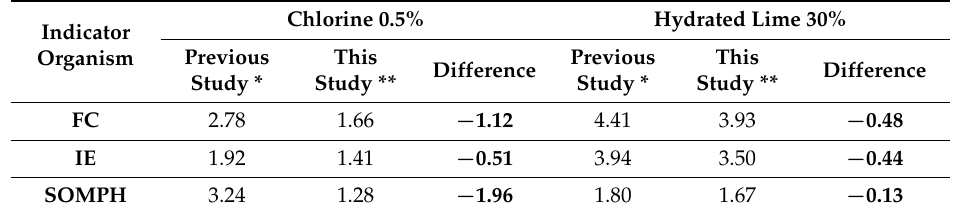
Table 2. Comparison of treatment efficacy (log reduction of indicator organisms (faecal coliforms (FC), intestinal enterococci (IE) and somatic coliphages (SOMPH)) with respect to the volume of chlorine or lime suspension used during current and previous studies